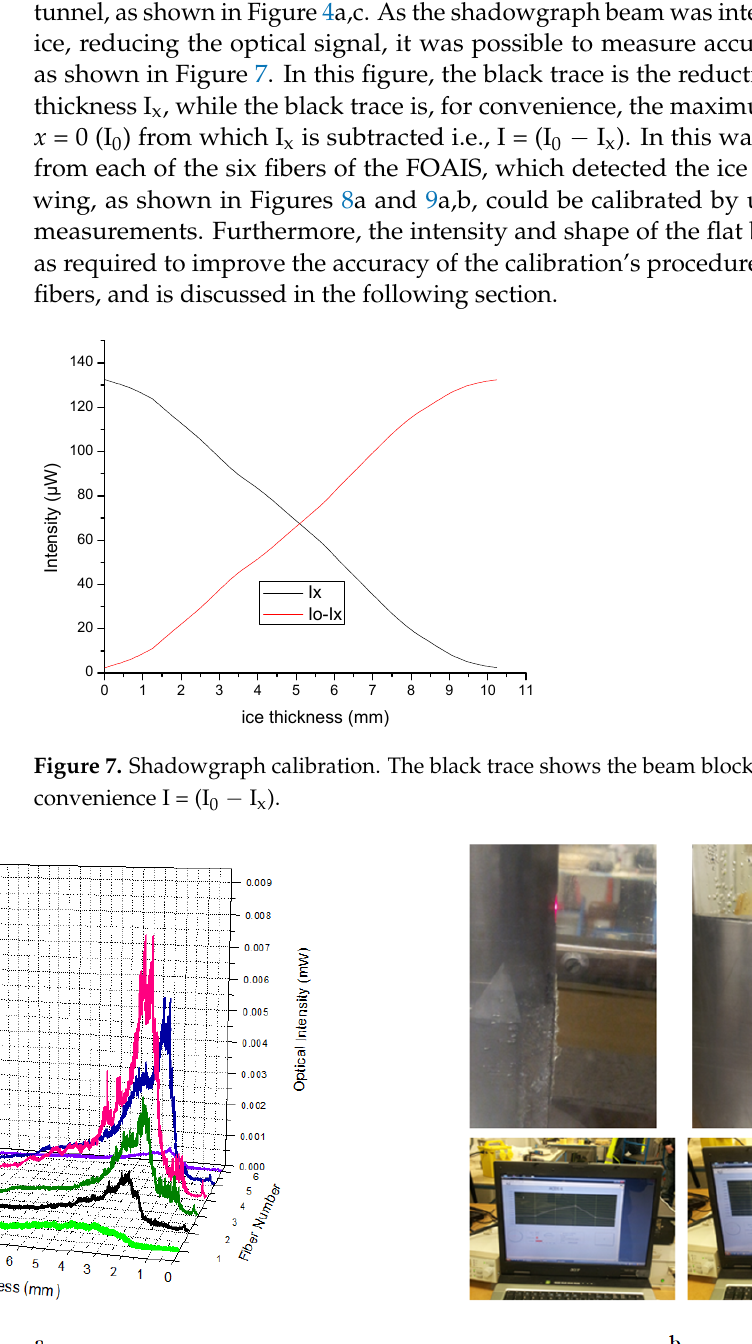
Figure 8. ( a ) Typical ice growth curves obtained by the fiber array ice sensor for glazed ice accreted at − 5 °C to − 7 °C. ( b ) Pictures from a typical icing tunnel run showing ice accession together with the corresponding signals of the ice sensor during ice growth.